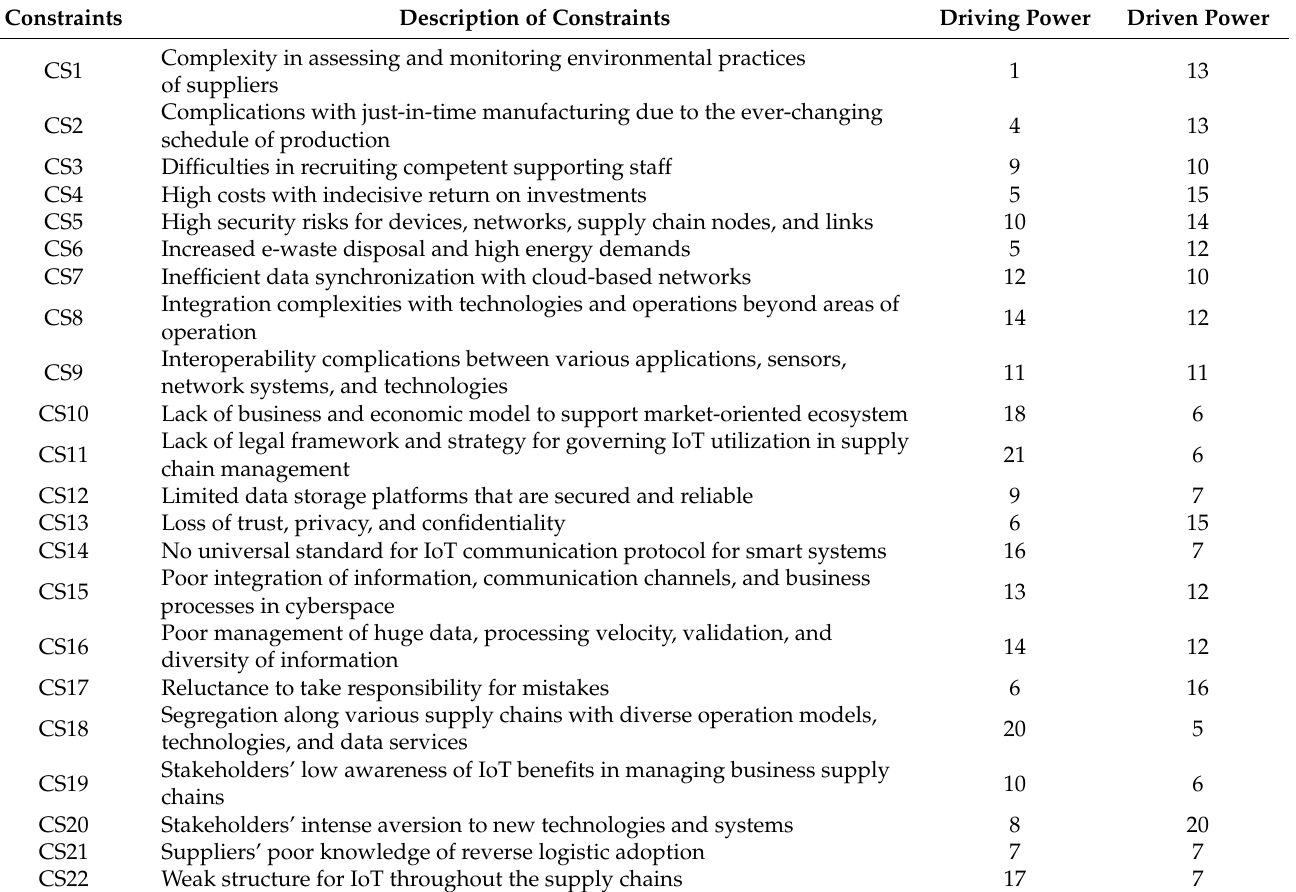
Table 5. Constraints’ driving and driven